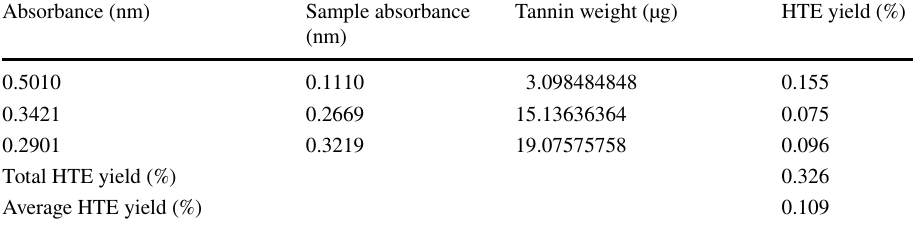
Table 4 The data for hydrolysable tannin extracts